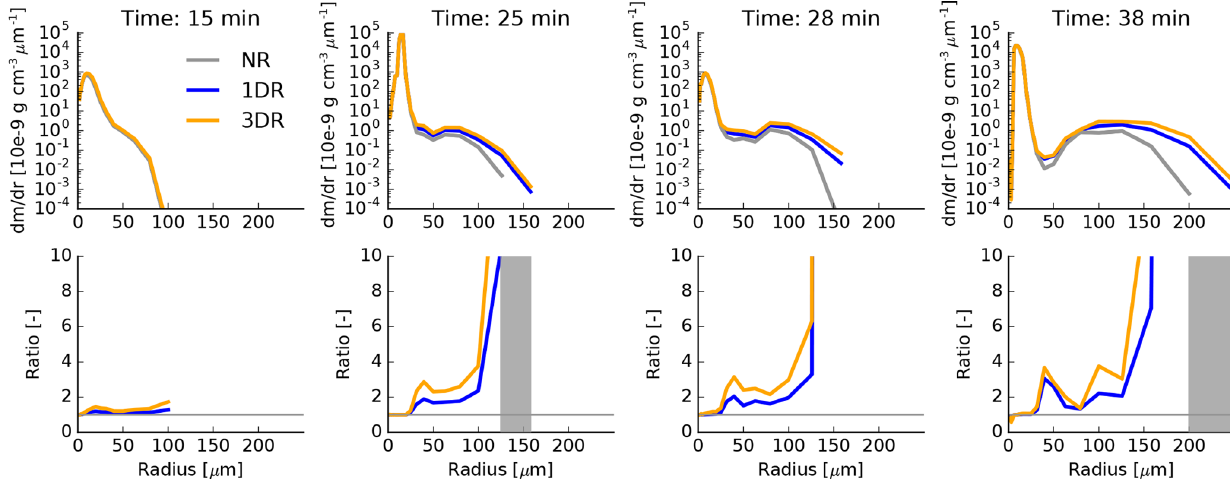
Figure 9. Similar to Fig. 6 but for the second selected parcel.